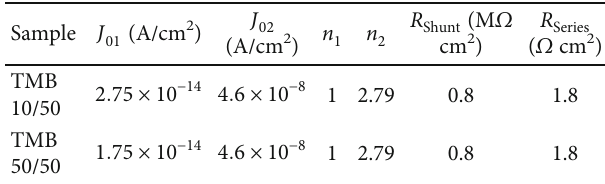
Table 5: Parameters used in fi tting I-V curves with the two-diode model. The values of R and R are obtained from the fi Shunt Series